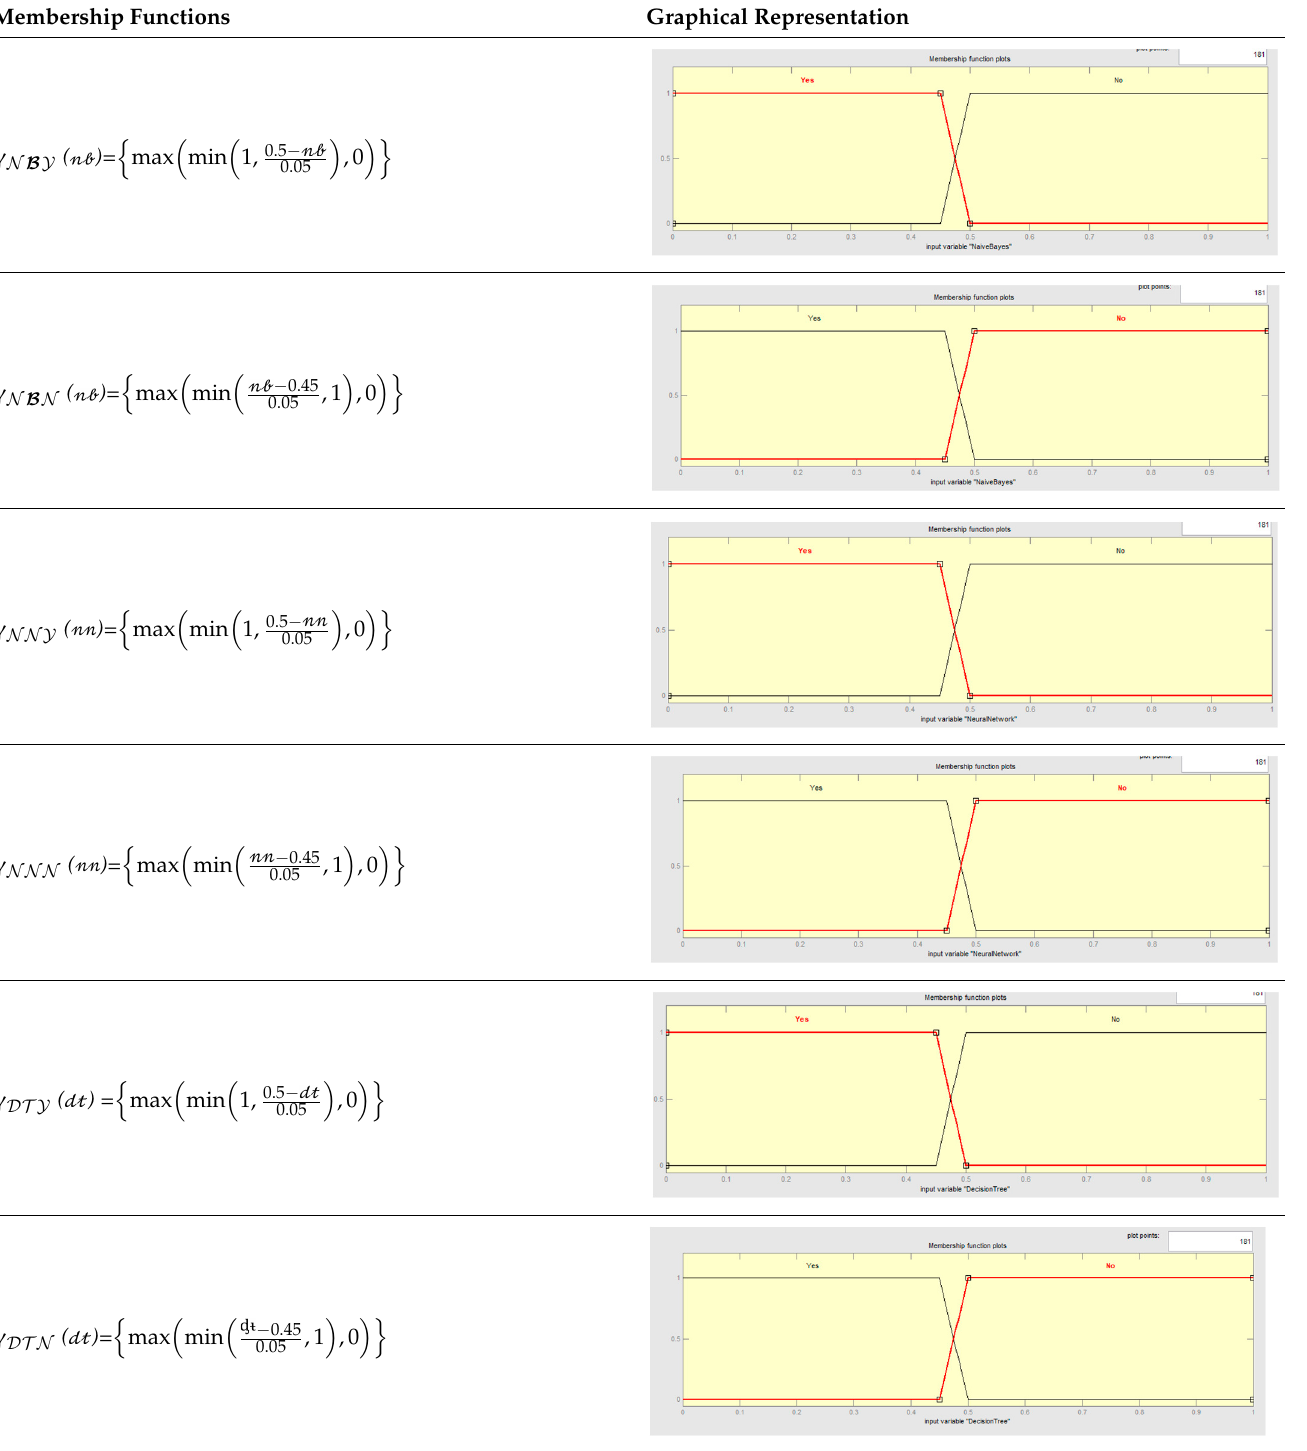
Table 2. Membership functions of the proposed fuzzy logic-based fusion technique.